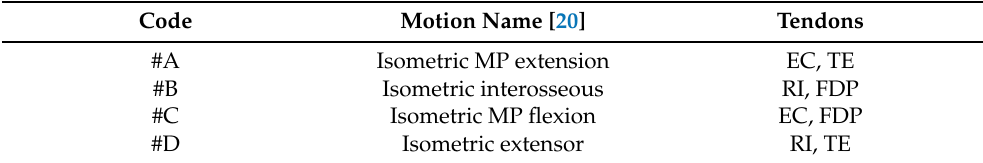
Table 1. The bio-inspired motions of the robotic